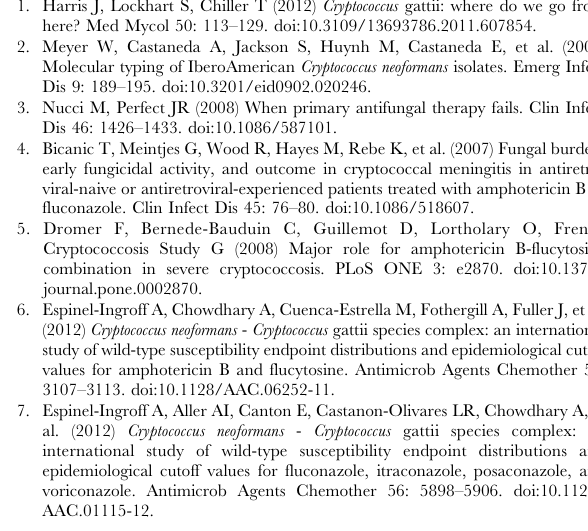
Figure S1 Details of dendrogram of M13 PCR fingerprint analysis of 219 clinical isolates of Cryptococcus neoformans - Cryptococcus gattii species complex collected in Taiwan during 1997 to 2010 and 12 reference strains.